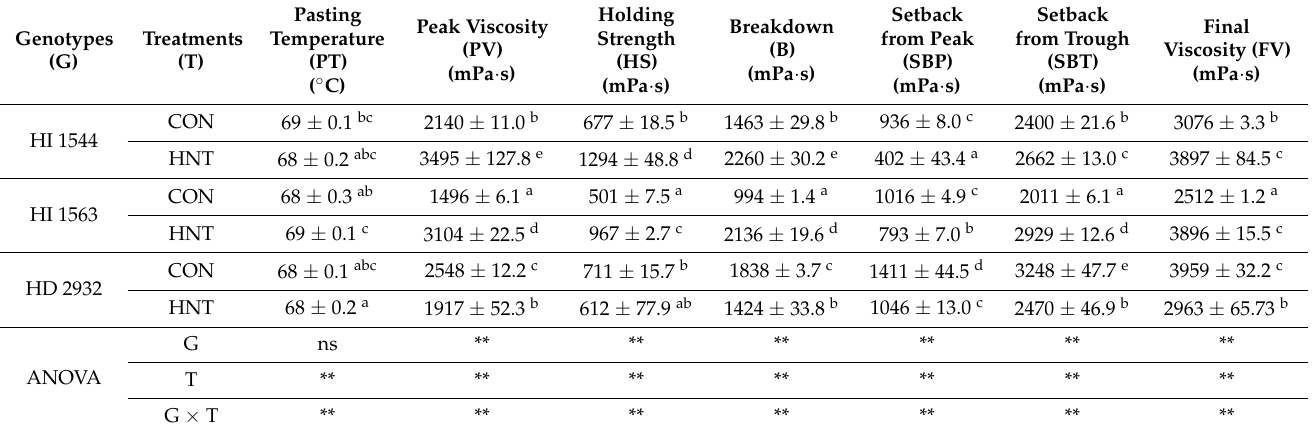
Table 5. Rheological properties of wheat flour in genotypes grown under control (CON) and HNT conditions. Values show mean ± SE. Data were obtained from three replications of each genotype. The separation of means was carried out using Duncan’s post hoc test ( p < 0.05). Means with different letters are significant. ** p < 0.01; ns: not significant ( p ≥